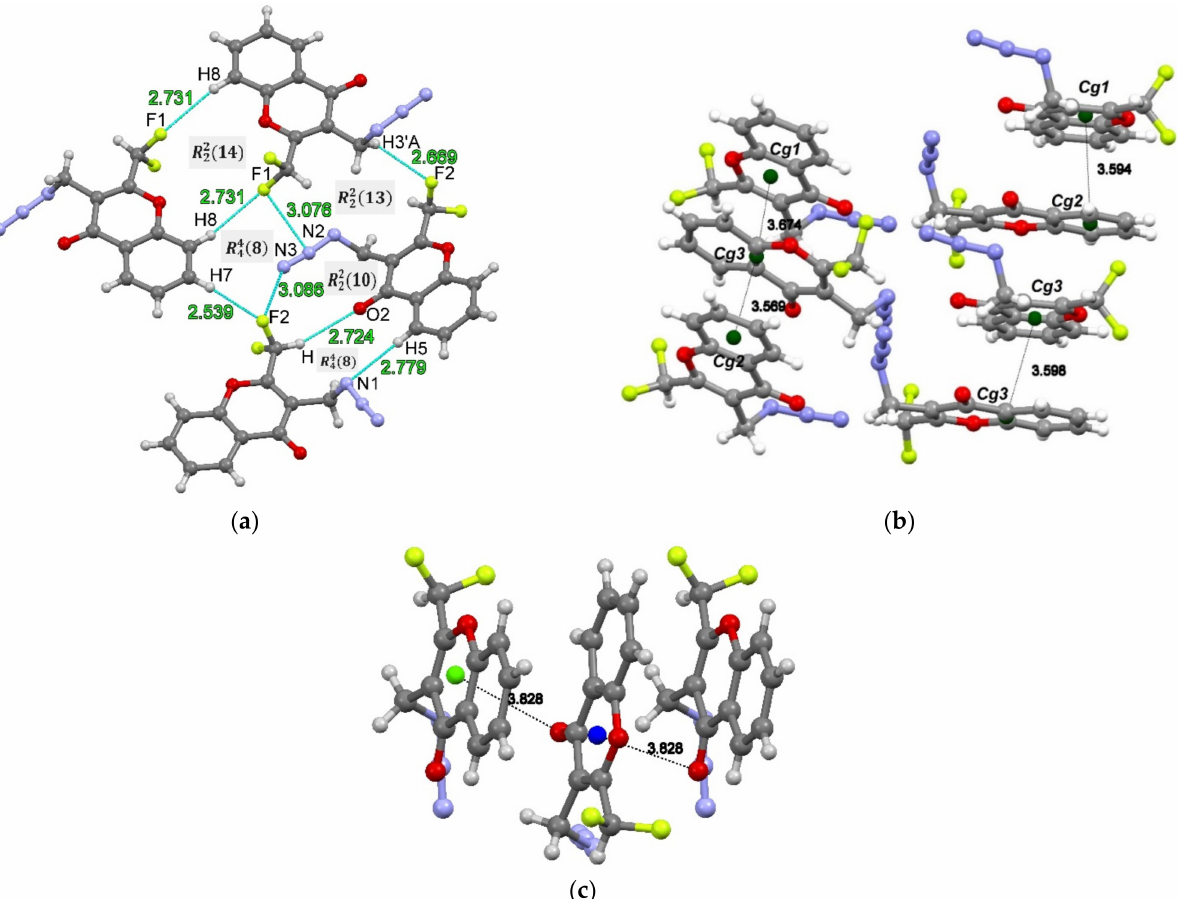
Figure 2. ( a ) Packing diagram of 4 via C sp2 –H ··· F–C sp3 and C sp3 –H ··· F–C sp3 intermolecular inter- actions (dotted lines). ( b ) A view of the π ··· π stacking intercentroids distances of 4 . ( c ) A view of C–O ··· π stacking (dashed lines) for compound 4